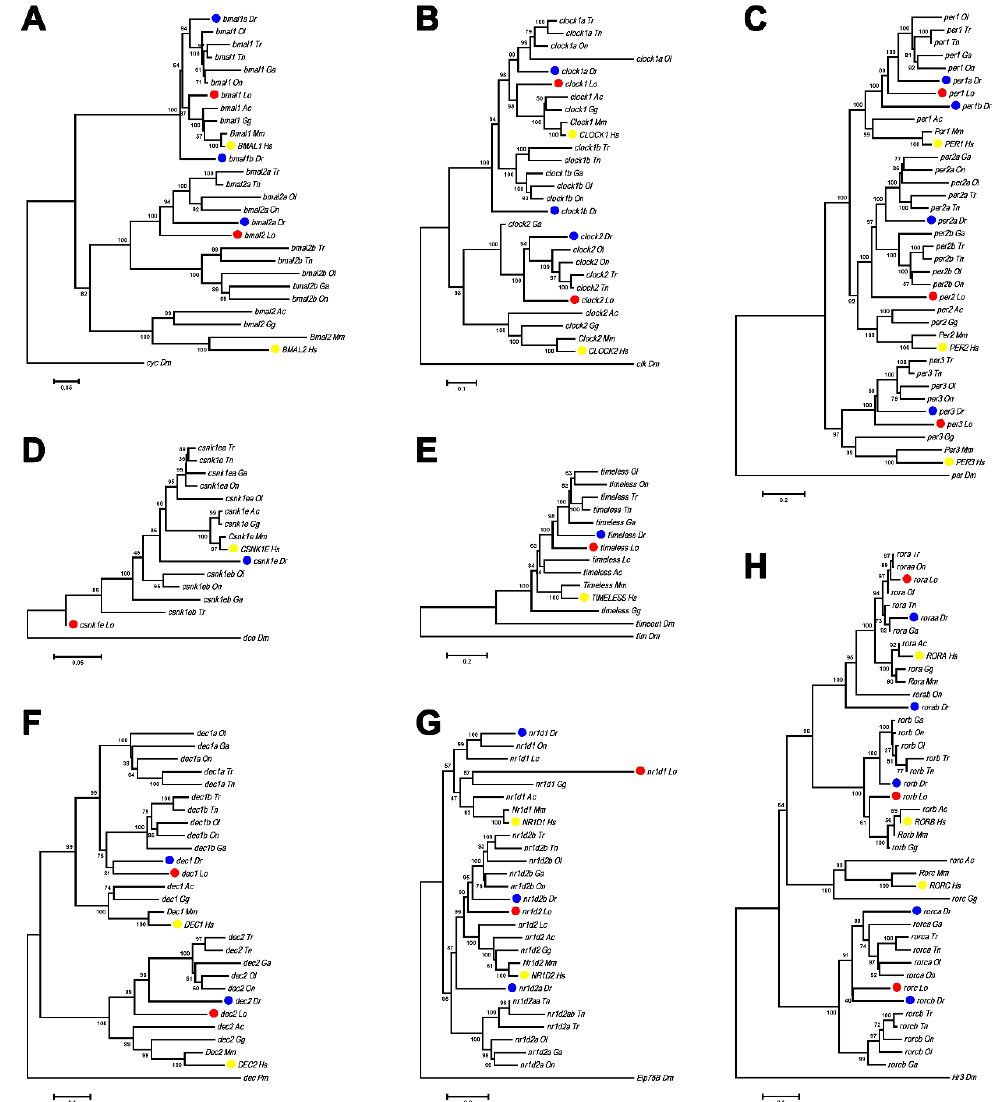
Figure 1. The phylogenetic trees of circadian clock genes. ( A ) bmal genes; ( B ) clock genes; ( C ) per genes; ( D ) csnk1e genes; ( E ) tim genes; ( F ) dec genes; ( G ) nr1d genes; ( H ) ror genes. The trees were constructed by the neighbor-joining method with MEGA6 [33], and the numbers on the nodes are percent bootstrap values based on 1000 pseudoreplications. The outgroups are ortholog genes in fly or lamprey. Red dots indicate spotted gar genes, blue dots indicate zebrafish genes, and yellow dots indicate human genes. The sequences used are listed in Supplementary Table S1.